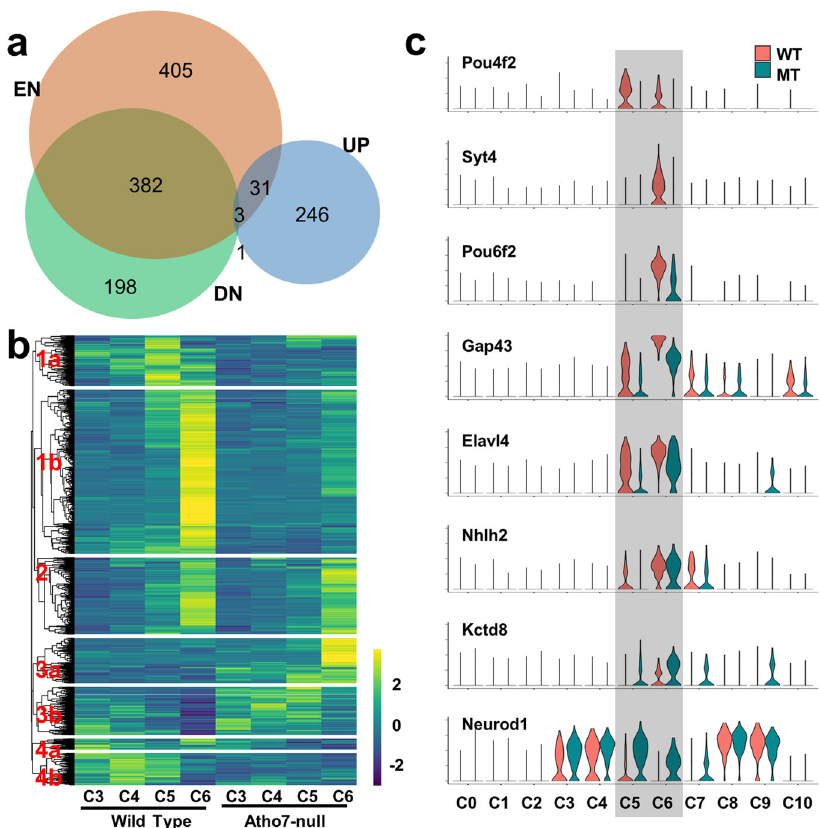
Fig. 8 Gene expression underlying the retinal ganglion cell (RGC) lineage in the Atoh7 -null retina. a Overlaps of down- and upregulated DEGs (DN and UP, respectively) in Atoh7 -null RGCs and RGC-enriched genes (EN) as presented by a Venn-diagram. Source data are provided. b Euclidean distance clustering demonstrating seven different modes of changes in gene expression in Atoh7 -null retinal RGCs (C5 and C6, see main text for details). For comparison, expression in C3 and C4 are also presented. The color scale represents relative expression levels which were generated by averaging the normalized gene expression values in each cluster and then centering and scaling the values in each row using R bioconductor package “ pheatmap ” (see “ Methods ” ). c Example genes with different modes of expression as demonstrated by violin plots, showing their expression levels (heights of plots, representing natural-log transformed normalized gene expression levels as described in “ Methods ” ) across all clusters of wild-type (WT, red) and Atoh7 - null (MT, blue) cells. Pou4f2 is from group 1a in ( b ), Syt4 , Pou6f2 , Gap43 , and Elavl4 are from group 1b, Nhlh2 is from group 2, Kctd8 is from group 3a, and Neurod1 is from group